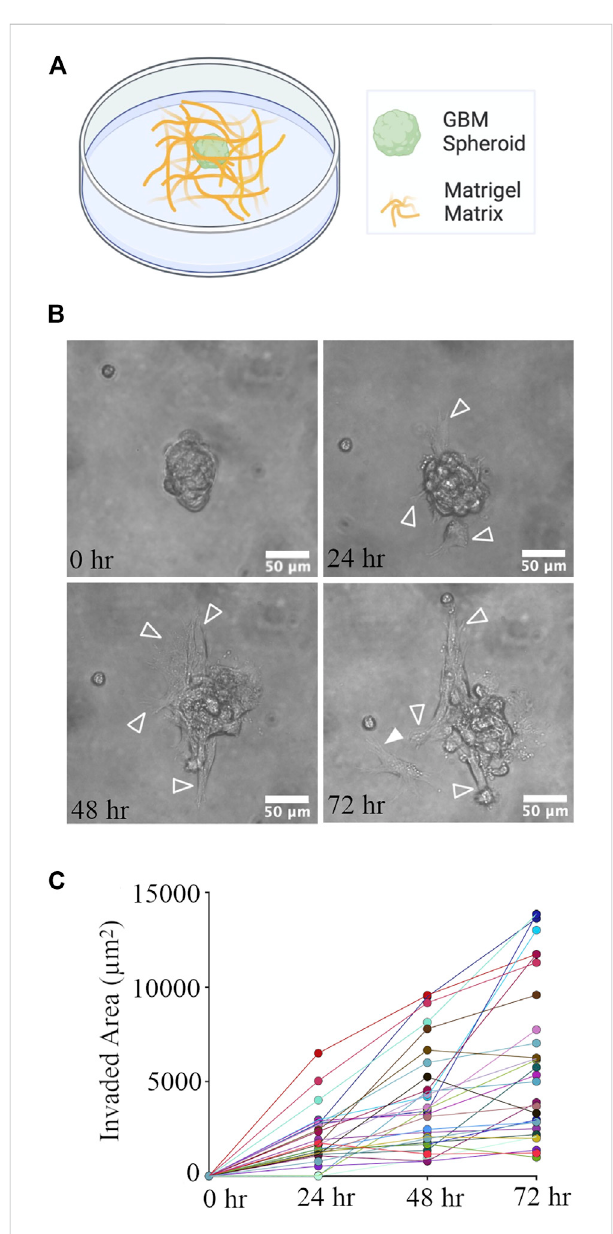
FIGURE 4 GBM Spheroid embedded in Matrigel matrix. (A) Schematic of a GBM spheroid in Matrigel. (B) Time-lapse imaging of a GBM spheroid. Arrowheads show invasive protrusions, and the solid arrowhead shows a detached GBM cell. Scale bar is 50 μ m. (C) Quanti fi cationoftheinvadedareaatdifferenttimepoints.N=28GBM spheroids at each time